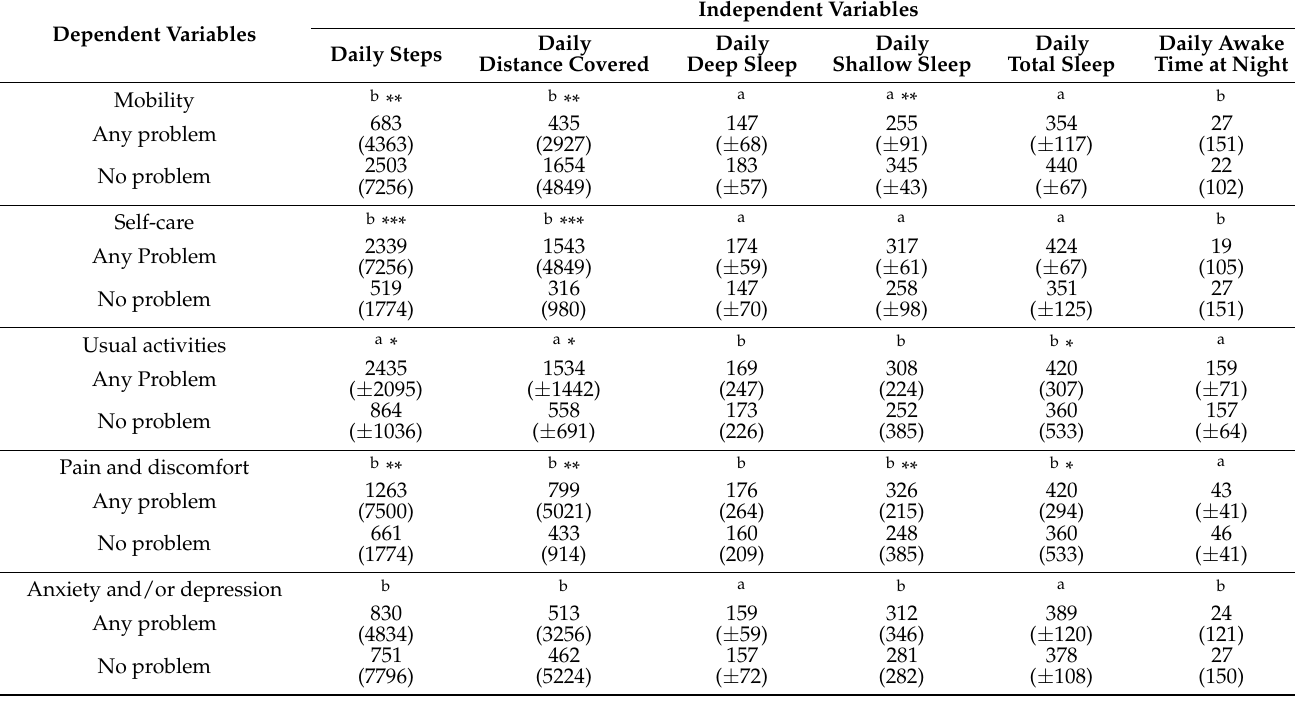
Table 4. Associations between descriptive dimensions of EQ-5D-5L and Xiaomi Mi Band 2 parameters. Dependent